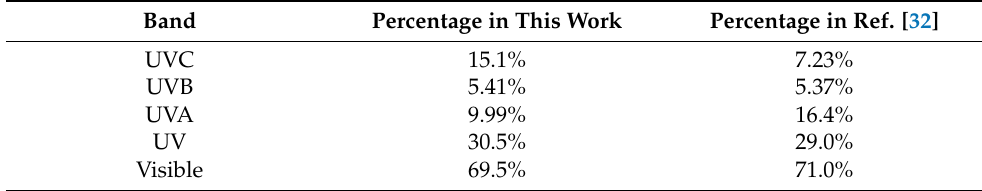
Table 2. Percentage of each band spectral irradiance in the UV–visible spectrum of pulsed xenon lamp.